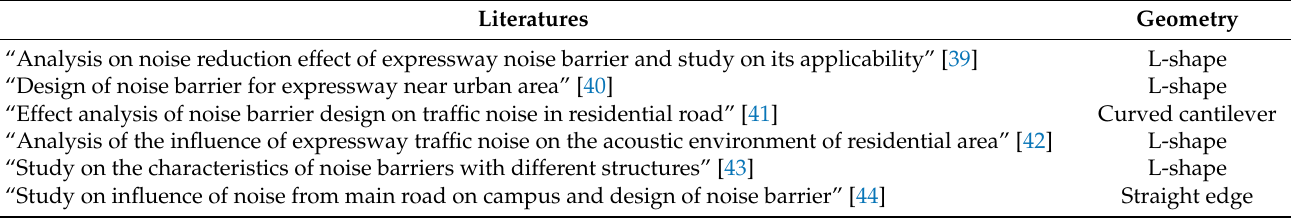
Table 2. Literature review of the geometry of noise barriers .